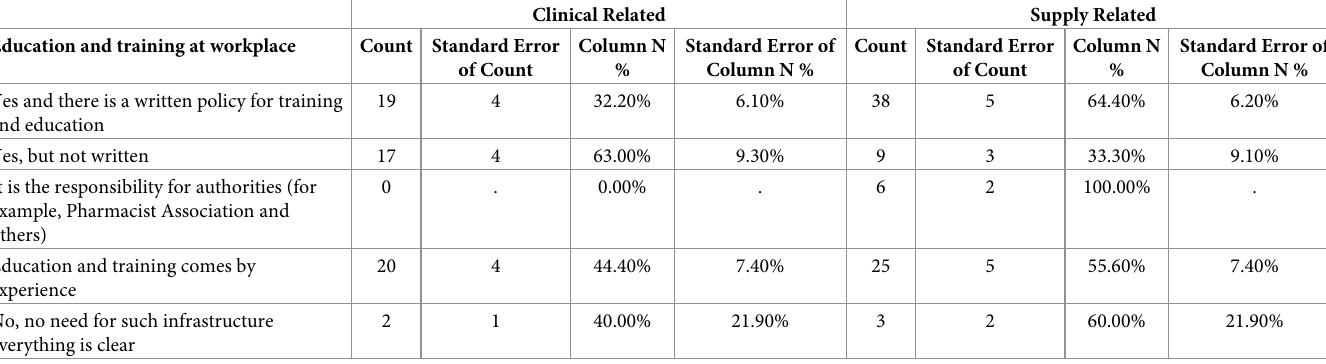
Table 4. The availability of pharmaceutical education and training based on the specialty field within RMS group.